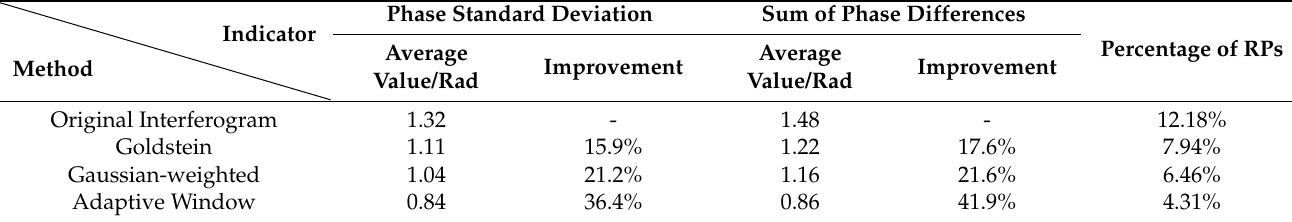
Table 2. Quality evaluation of differential interferograms.